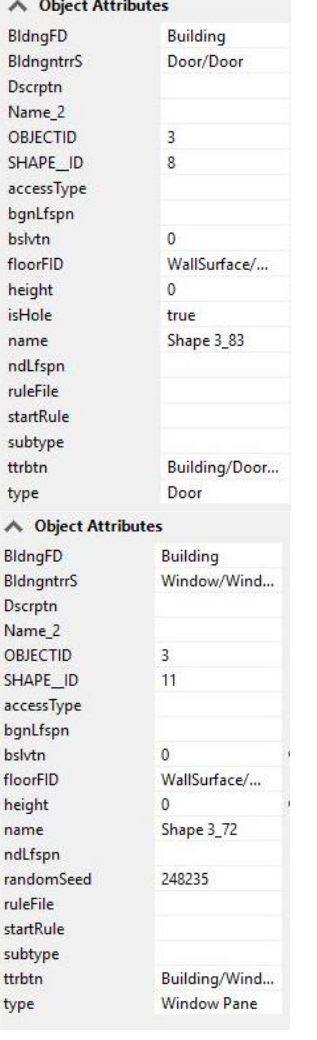
Figure 14: Left the attributes of the door. Right the attributes of